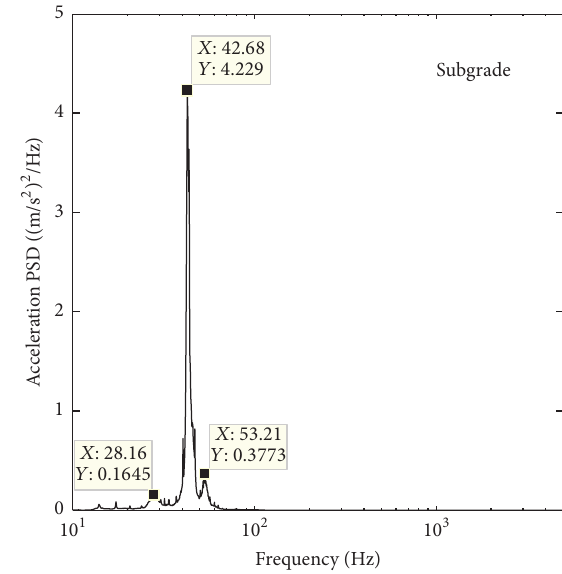
Figure 7: The acceleration power spectrum of the rail.